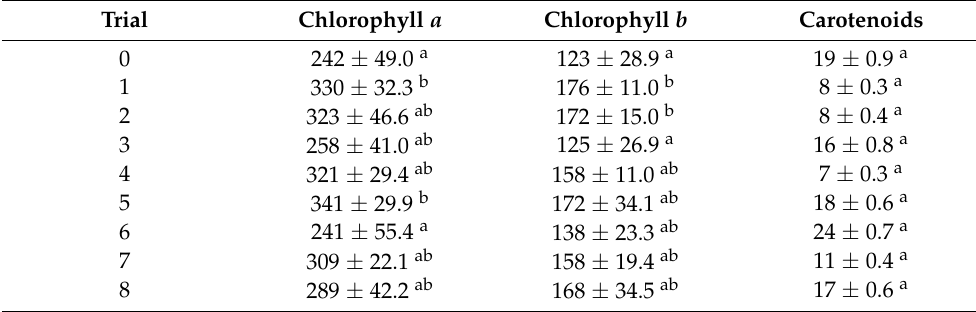
Table 3. Chlorophyll and carotenoids content in spinach leaves expressed as mg kg − 1 fresh weight (mean value ± standard deviation) 1 cultivated in trials